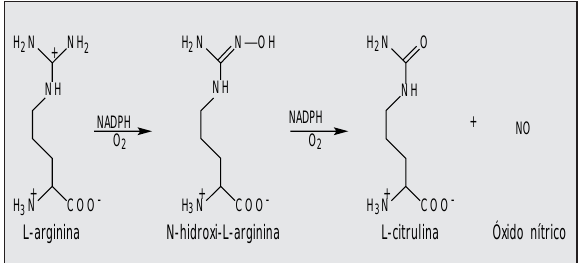
Figura 3 – Formação de guanosina monofosfato cíclica (GMPc), a partir da guanosina trifosfato (GTP), mediada por